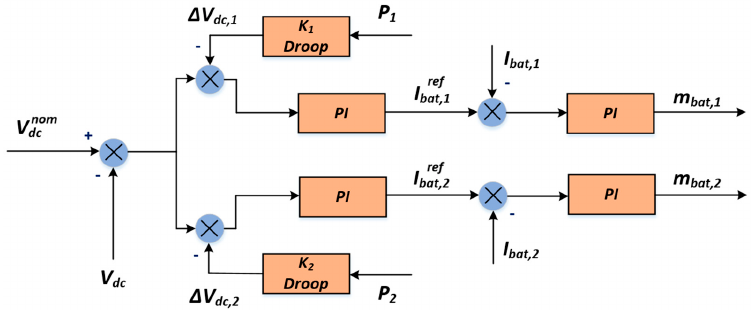
Figure 3. The proposed droop-based cascaded control scheme.